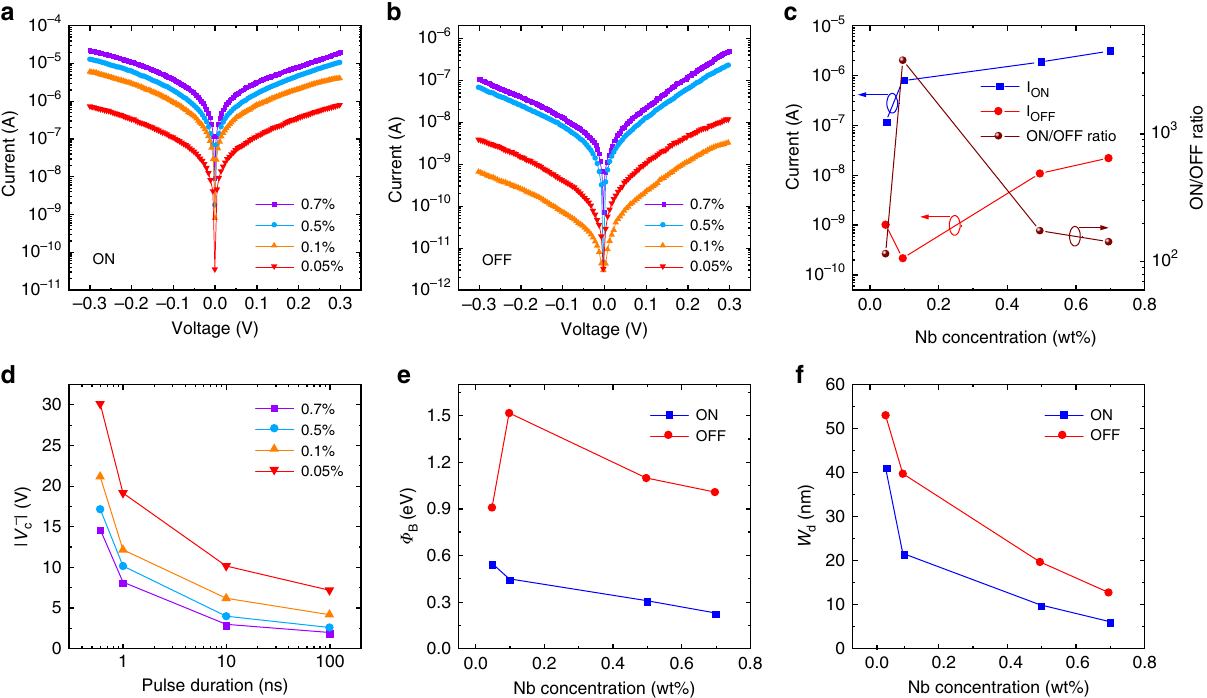
Fig. 5 Effect of Nb-doping concentration. a , b I – V curves of the ON and the OFF states, respectively. c Junction currents and ON/OFF ratios at different Nb concentrations, read at 0.1 V. d Absolute values of the coercive voltage | V c − | versus the pulse duration t d with different Nb-doping concentrations. e Schottky barrier height ( Φ B ) and f depleted region width W d of the ON and the OFF states as a function of Nb